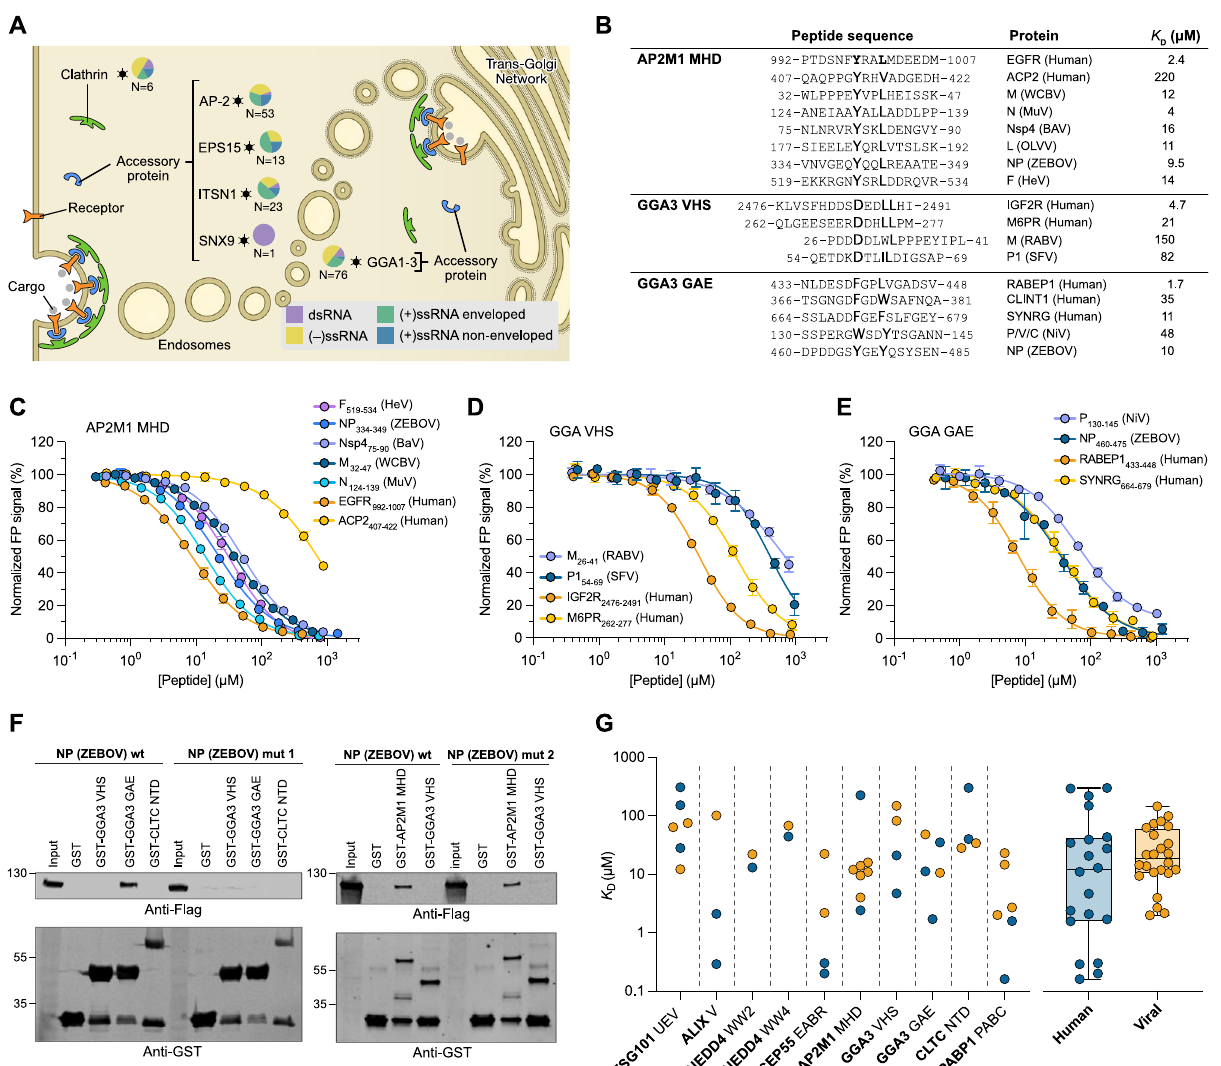
Fig.4|Viralmimicryofdistincttraf fi ckingmotifsbindingtoclathrinadapters. A Schematic representation of clathrin adapter vesicle coatcomponents forwhich viralligandswerefound:AP2B1andAP2M1(collapsedasAP-2),CLTC,EPS15,ITSN1, SNX9, GGA1, GGA2, and GGA3 (collapsed as GGA1-3). Pie charts show the class of viral species hijacking the domain. N indicates the number of identi fi ed interac- tions. B Overview of af fi nity data for peptides interacting with clathrin adapter proteins. C – E FP-monitoredaf fi